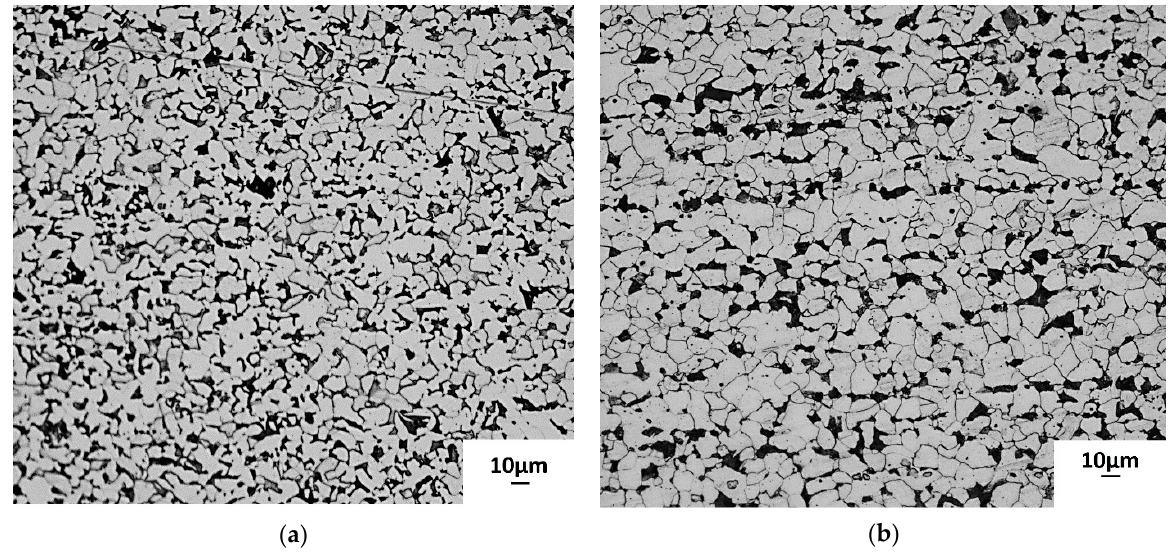
Figure 2. Optical micrographs for normalized AISI 1020 steel ( a ) before and ( b ) after hot-dip galvanizing. Table 2. Ferrite grain and pearlite block sizes for normalized AISI 1020 steel before and after galvanizing. Microstructure Ferrite Grain Size ( µ m) Pearlite Block Size ( µ m) Interlamellar Spacing ( µ m) Non-galvanized steel